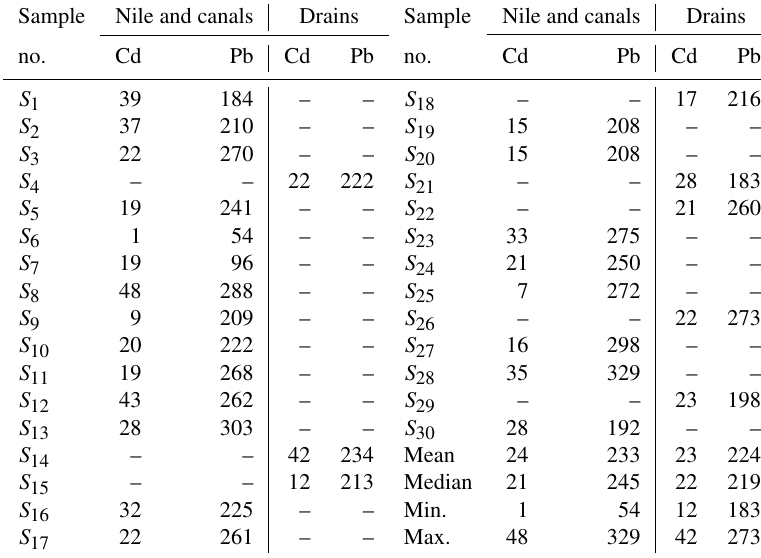
Table 2. Cd and Pb concentrations in the surface water samples (µgL − 1